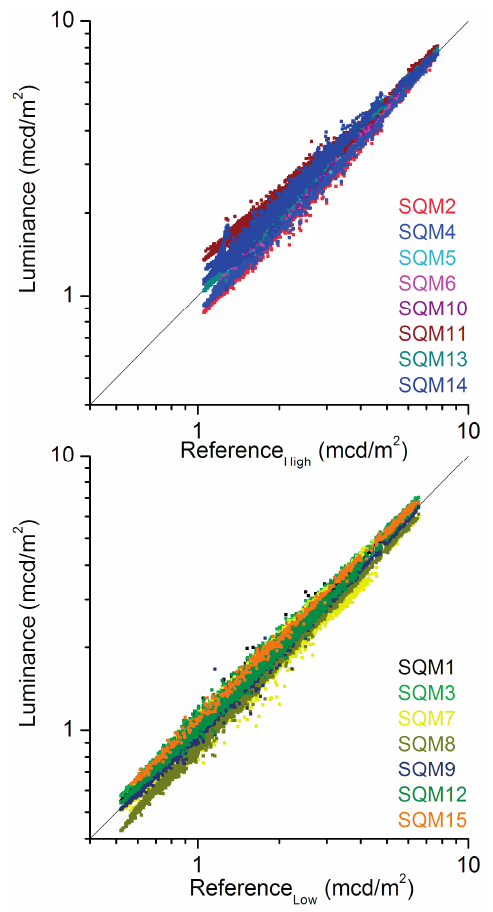
Figure 4. Top panel: measured luminance vs. reference for group H. Bottom panel: measured luminance vs. reference for group